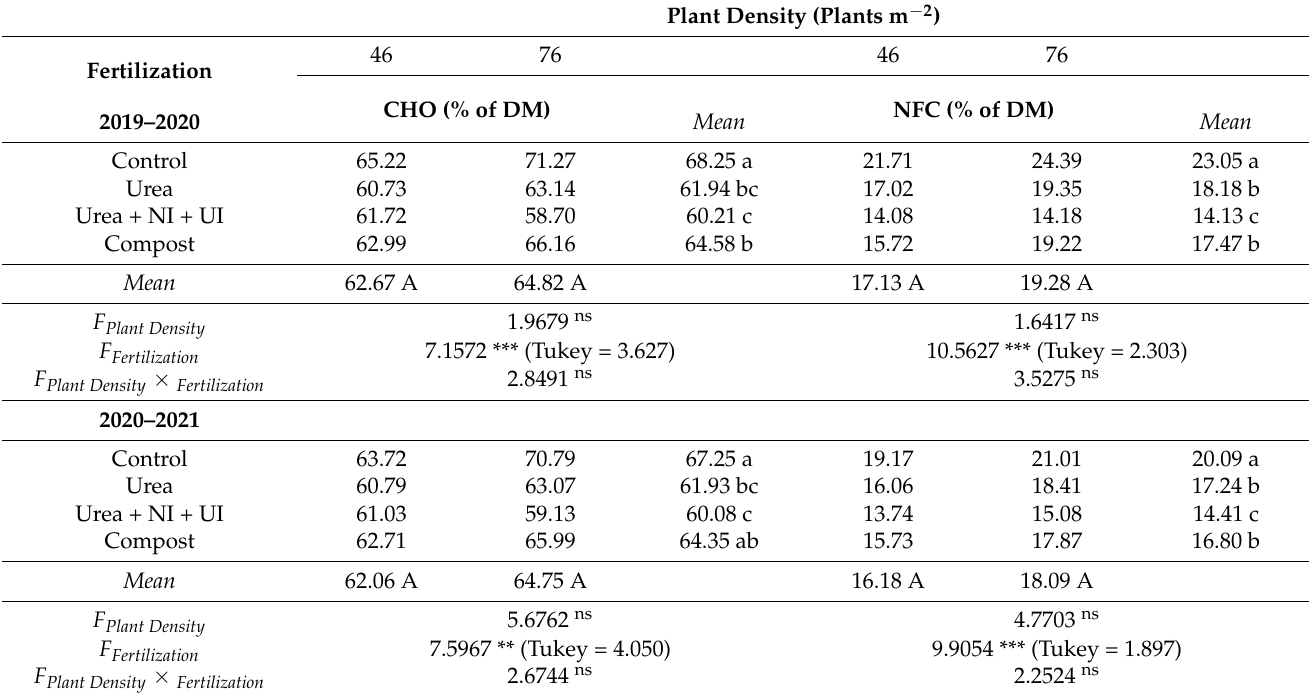
Table 4. Total carbohydrate (CHO) and non-fiber carbohydrate (NFC) content as influenced by the plant density and